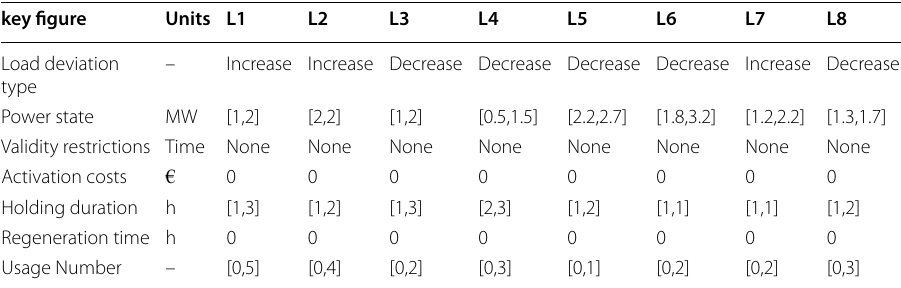
Table 6 Characteristics of the loads’ key figures of use case III based on the description of the EFDM key